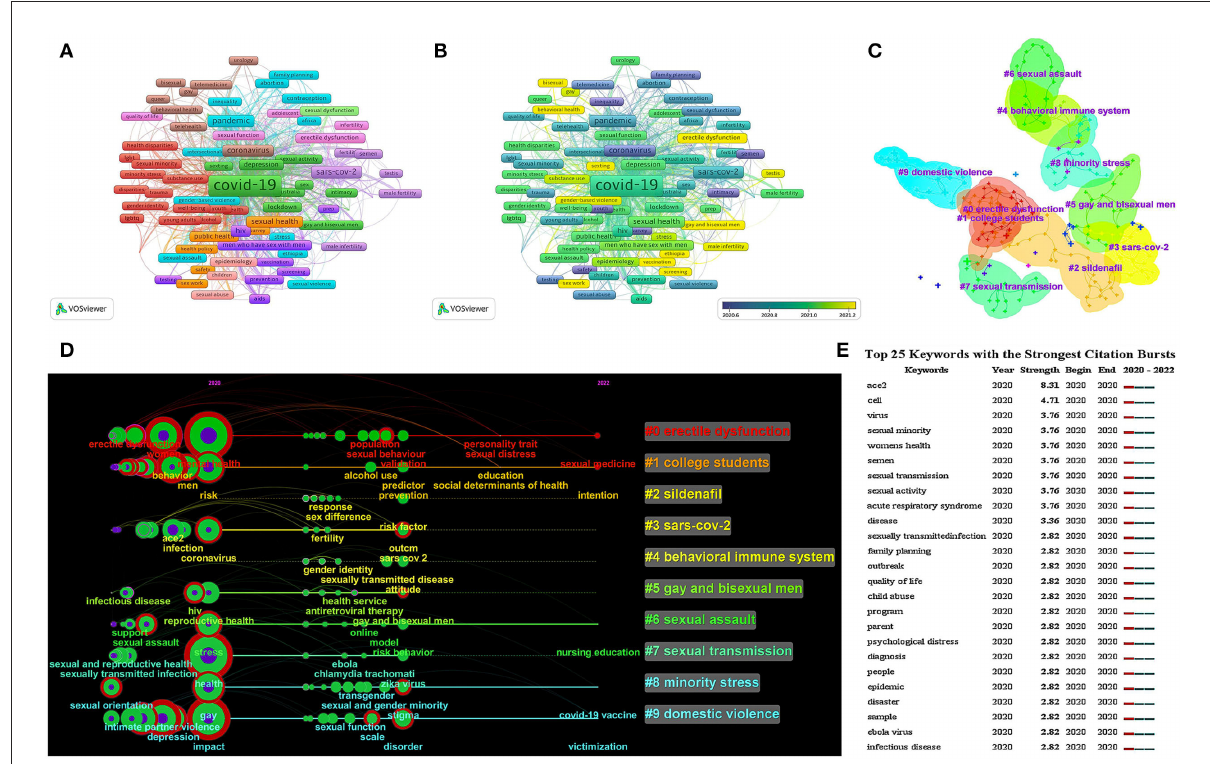
FIGURE7 Visualization map of keywords in studies. (A) Co-occurrence network of keywords. (B) Overlay visualization map based on the occurrences of keywords. (C) Cluster analysis of keywords. Different patterns represent a cluster. (D) Timeline cluster map of keywords from January 1, 2020, to March 12, 2022. (E) Top 25 keywords with the strongest citation bursts.